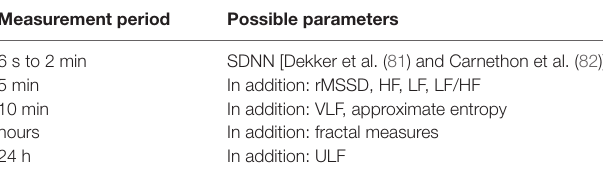
Table 1 | Measurement period and